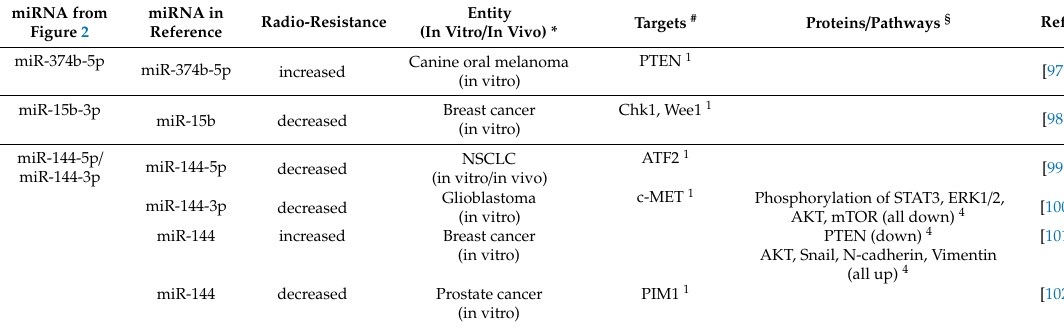
Table 2. miRNAs from Figure 2 and their association with radioresistance. miRNAs, their e ff ect on radioresistance (increased or decreased), the entity, the identified target genes, and proteins / pathways. miRNA from miRNA in Entity # Proteins / Pathways § Ref. Figure 2 Reference Radio-Resistance (In Vitro / In Vivo) * Targets miR-374b-5p miR-374b-5p PTEN 1 Canine oral melanoma increased (in vitro) miR-15b-3p Breast cancer miR-15b decreased (in